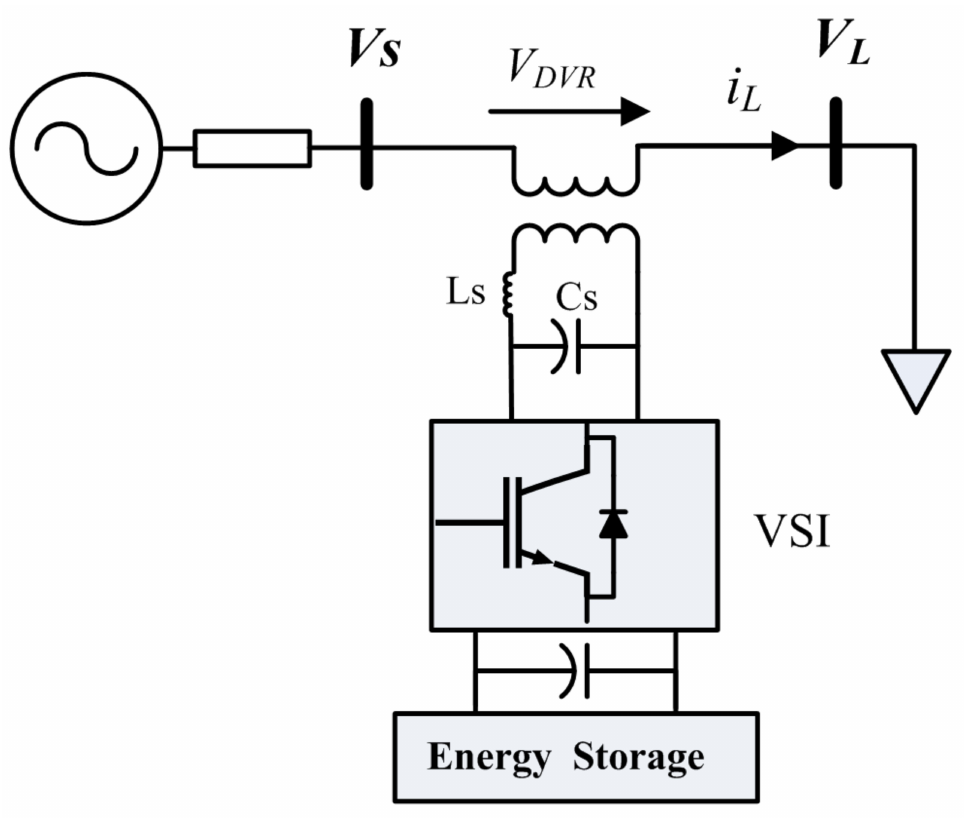
Figure 3. Power circuit of